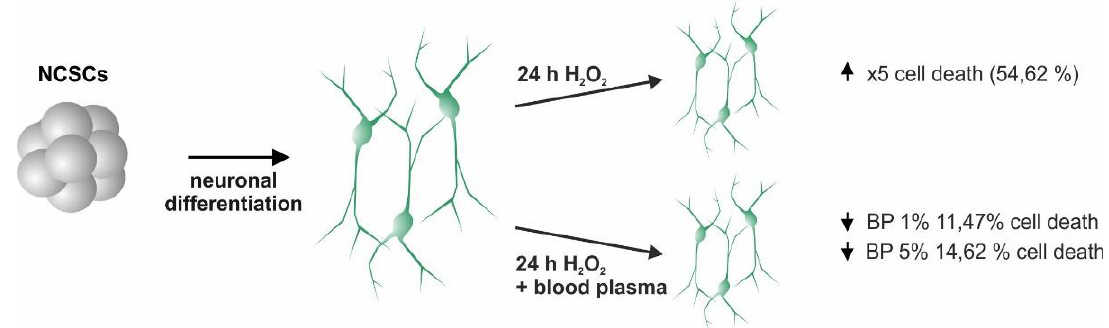
Figure 5. Plasma reduces cell death of inferior turbinate stem cell (ITSC)-derived neurons upon oxidative stress treatment. Application of 1% plasma reduces cell death to 11.47% as the application of 5% plasma reduces cell death to 14.62% (indicated by arrows). Oxidative stress treatment with H 2 O 2 leads to an increased death rate of 54.62% (indicated by arrow). Scheme summarizes the data shown in Figure 4. BP: blood plasma, H 2 O 2 : hydrogen peroxide.